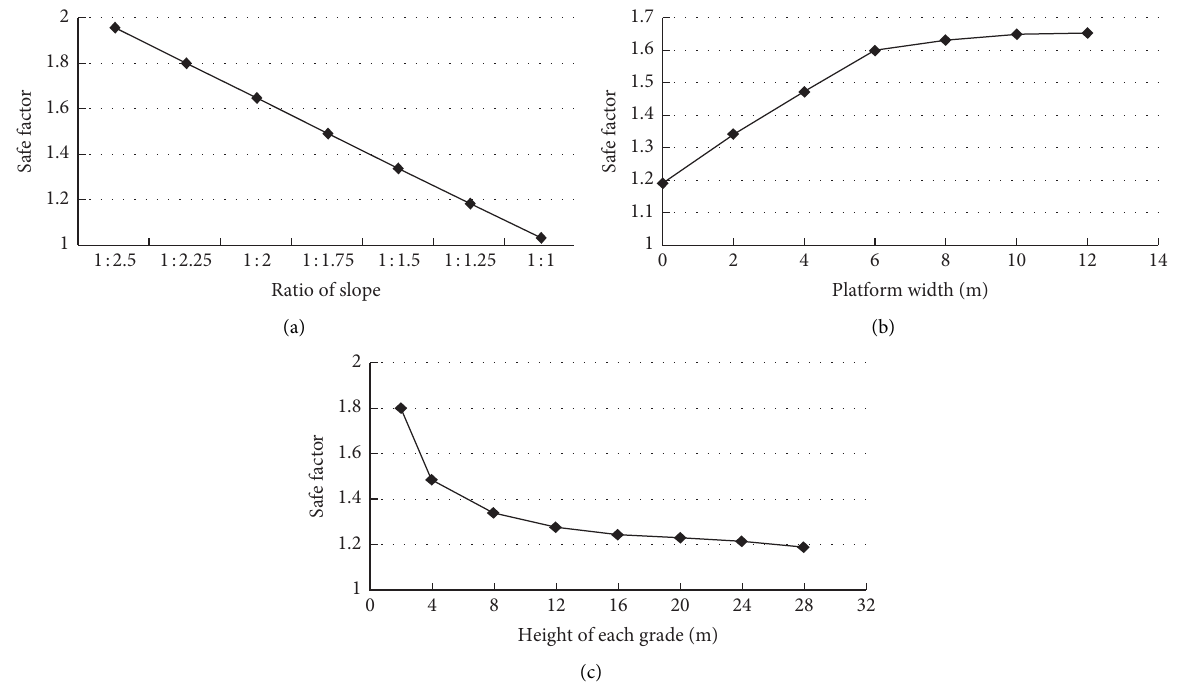
Figure 13: The diagram of the safety factor varies with the external factors. Table 3: The sensitivity coefficient of influence